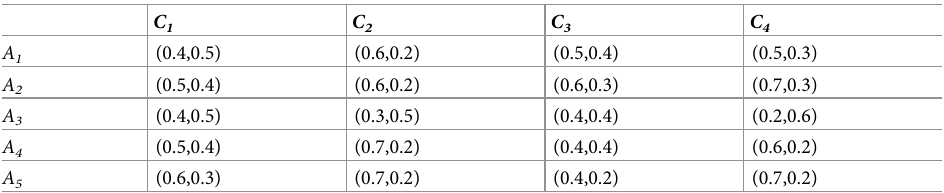
Table 2. The q -rung orthopair fuzzy decision matrix M 2 given by D 2 .